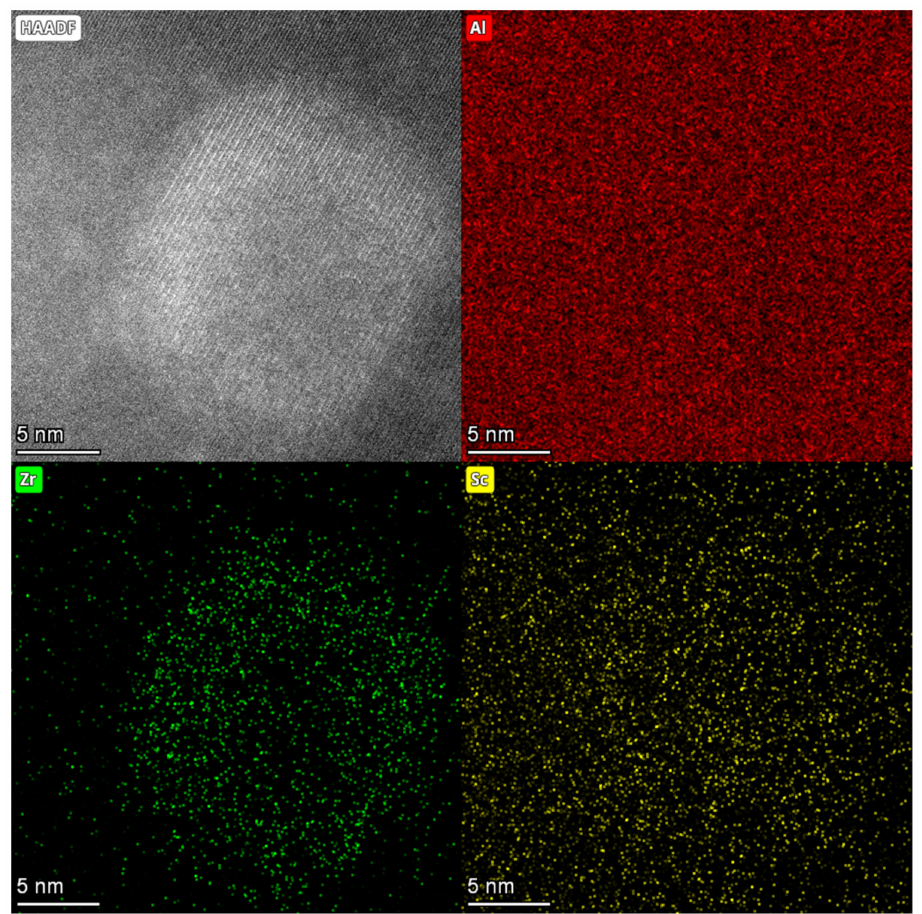
Figure 10. HAADF images and EDS plots of the Al 3 (Sc, Zr)/Al 3 Li core–shell particles in the S420